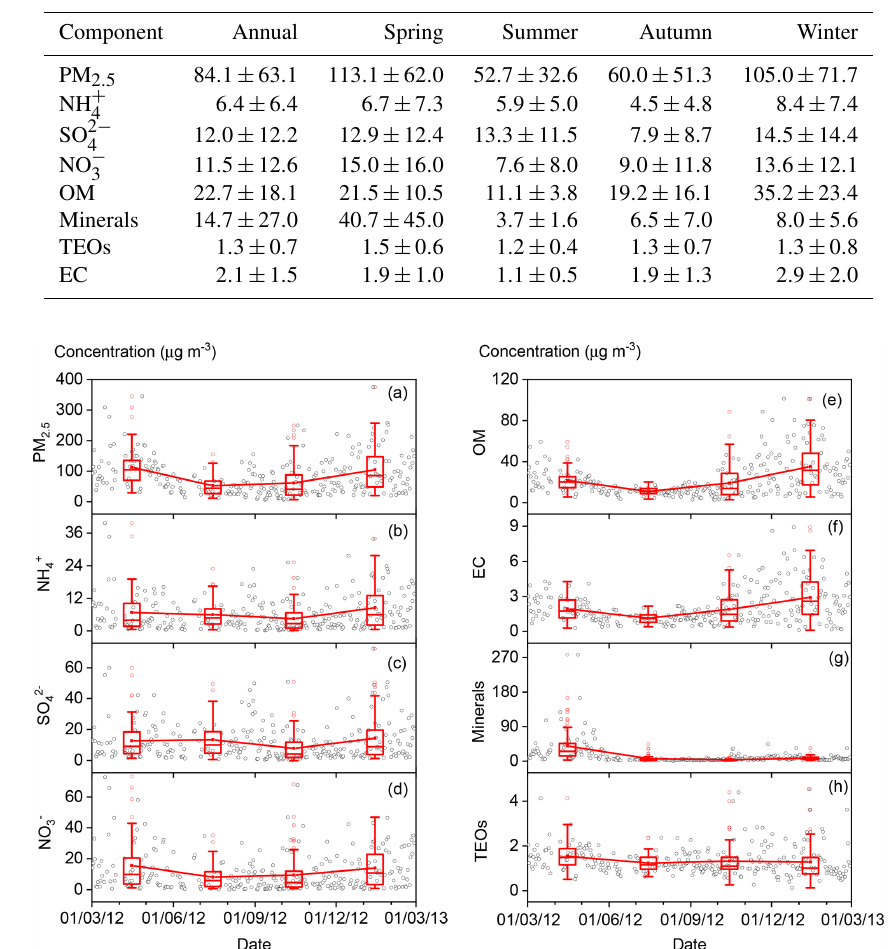
Figure 2. Time series of fine particulate matter (PM 2 . 5 ) concentrations and its seven major known components from March 2012 to 28 Febru- ary 2013 (open black circles). The boxes represent, from top to bottom, the 75th, 50th, and 25th percentiles for each season. The whiskers, solid red squares, and open red circles represent 1.5 times the interquartile range (IQR), seasonal mean values, and outlier data points,